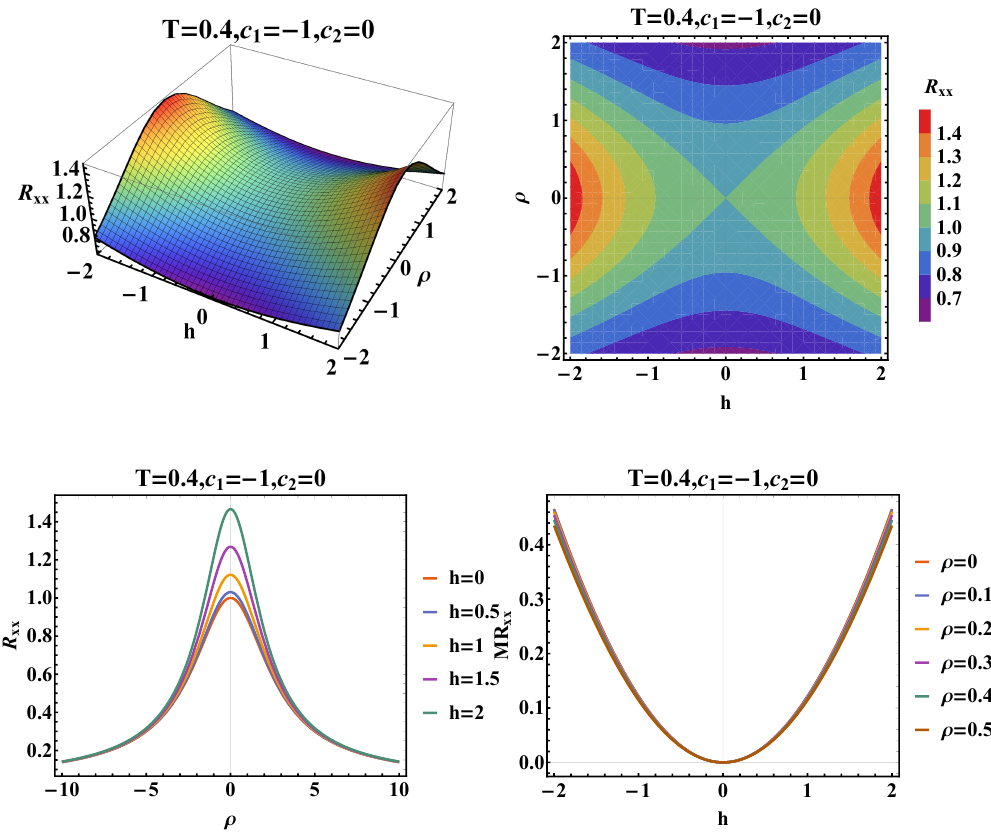
Figure 4 . Upper left: R xx as a function of ρ and h . Upper right: contour plot of R xx . Lower left: R xx vs ρ with h = 0 , 0 . 5 , 1 , 1 . 5 , 2 . Lower right: MR xx vs h with ρ = 0 , 0 . 1 , 0 . 2 , 0 . 3 , 0 . 4 , 0 . 5 . We set T = 0 . 4 , c 1 = − 1 , and c 2 = 0